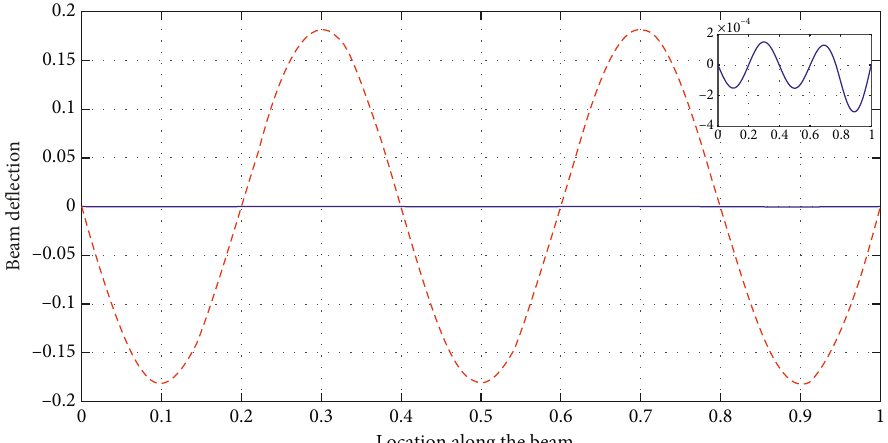
Figure 10: The steady-state deformed shape of a collocated controlled (solid line) and uncontrolled (dashed line) undamped simply supported beam when ω � 246.73, x f � 0.77, x n � 0.77, and x a � 0.9. The inset shows the detailed plot of the controlled